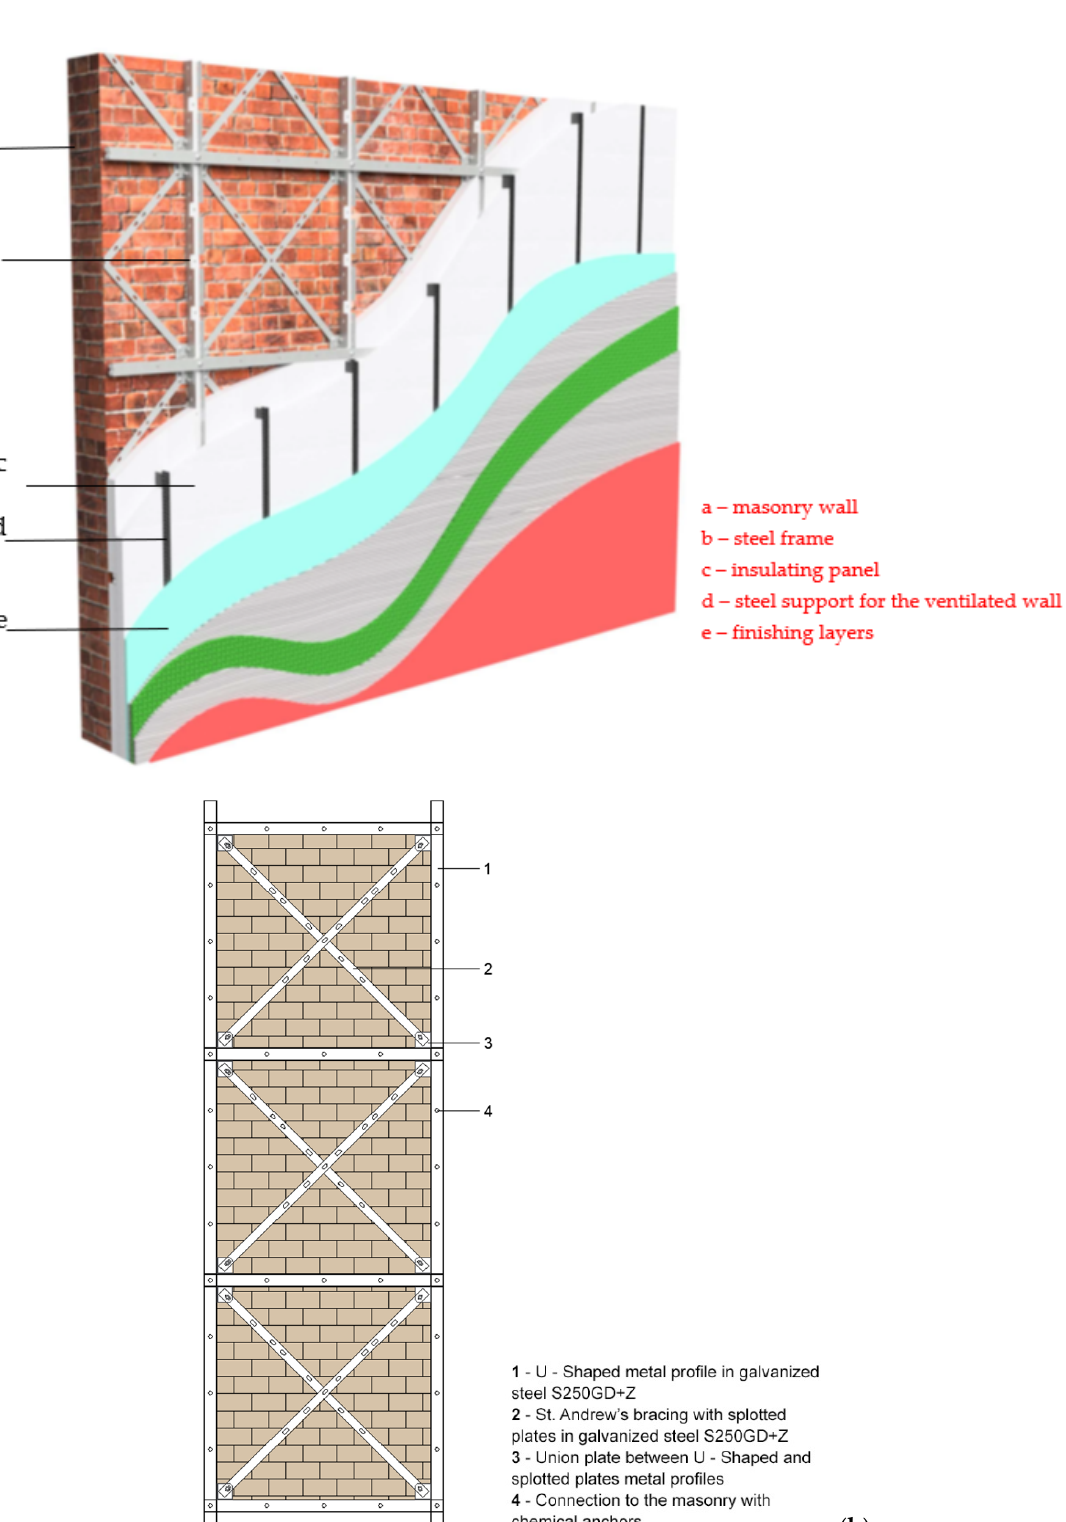
Figure 1. The Resisto 5.9 system: layers ( a ) and basic structural components ( b ). The CFS elements are placed in adhesion to the masonry by means of non-penetrat- ing chemical anchors, as shown in Figure 2, with injection of resin into holes of appropri- ate diameter and length following each other with a regular pitch.